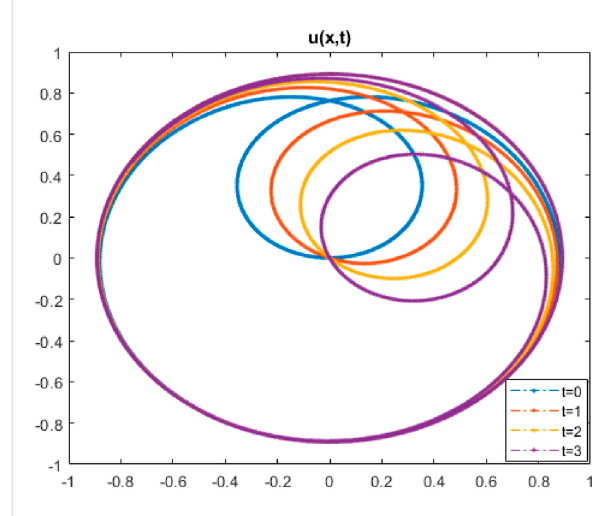
FIGURE 4 Trajectory of solution (3.16) with t for k = 1.1, c = − 2.8, and γ = 1.